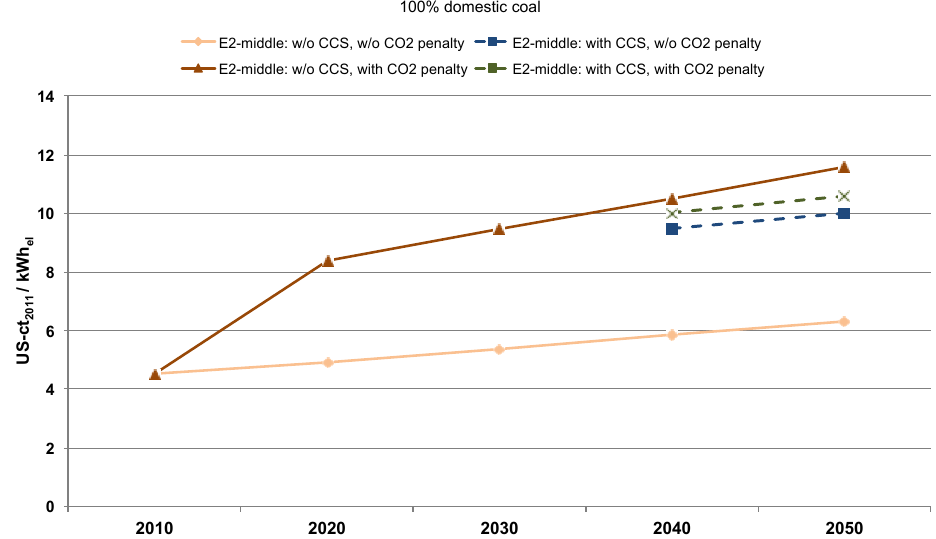
Figure 6. LCOE in South Africa for coal-fired supercritical power plants with and without CCS and with and without CO 2 costs in coal development pathway E2: middle.